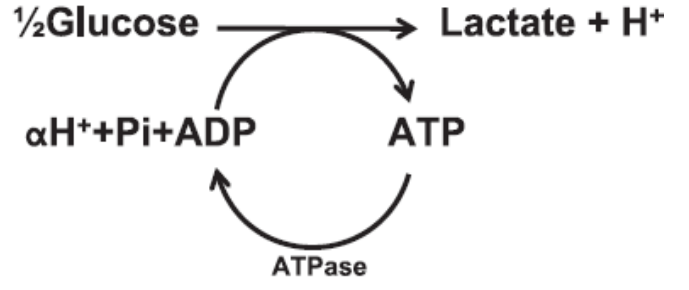
Figure 3. Anaerobic glycolysis and ATP hydrolysis schematic; carnosine buffers H +